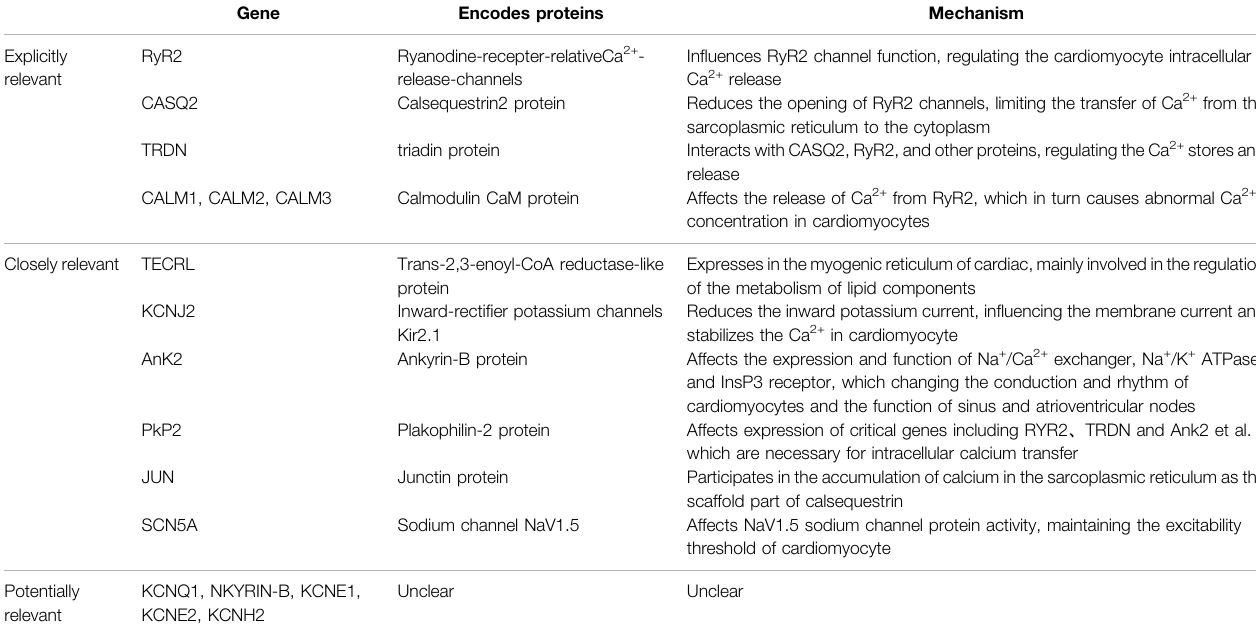
TABLE 1 | Relevant